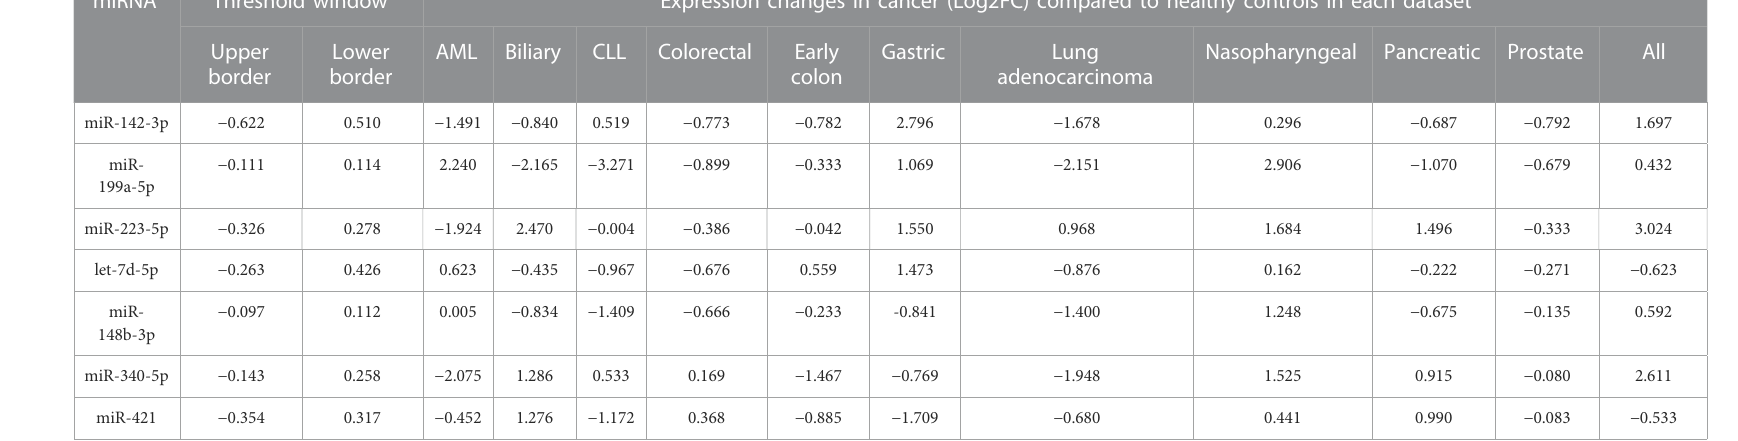
TABLE 2 The foldchange of 37 selected DEMs in 11 cancer datasets compared to control in respective datasets. The miRNAs with expression fold change levels inside the threshold window were discarded. Seven DEMs with the minimum oscillation (MAD) in healthy controls showed the highest dysregulation in 11 cancers cancer datasets. All miRNAs indicated MAD score < 0.2. AML: acute myeloid leukemia, CLL: chronic lymphoid leukemia. ALL: acute lymphoid leukemia. MAD: median absolute fold